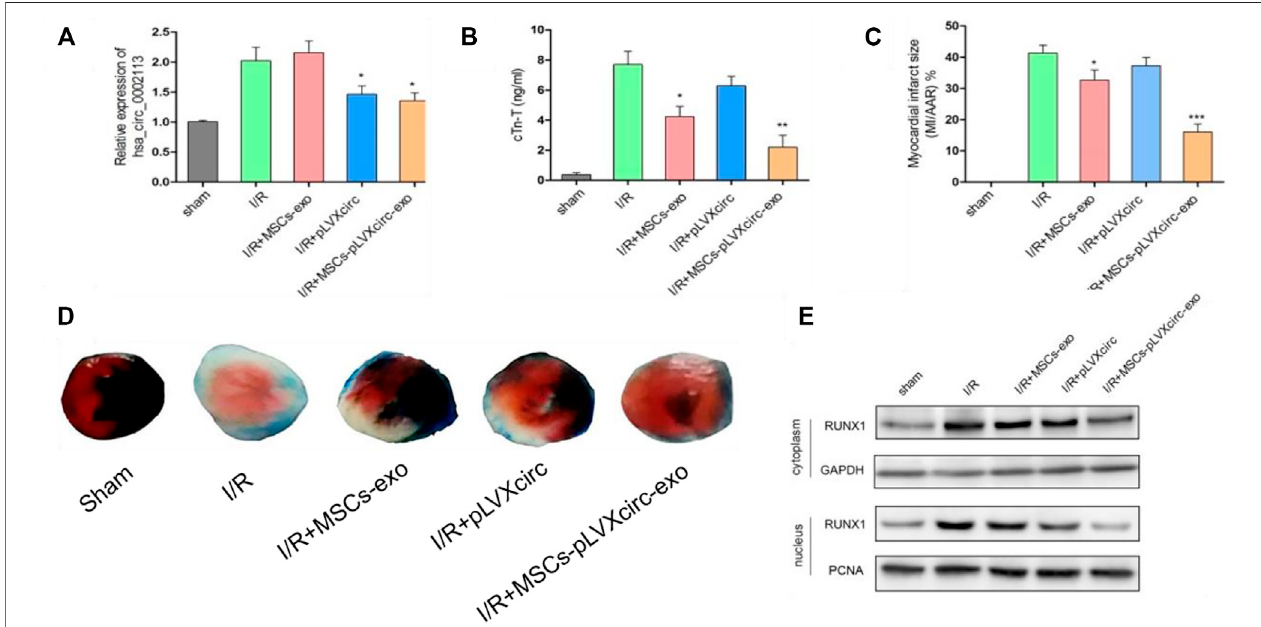
FIGURE 6 | Exosomes derived from pLVXcirc treated MSCs reduced the infarction size 4 weeks post-surgery. (A) The circRNA_0002113 expression was evaluatedaftertreatmentwithexosomesderivedfrompLVXcirctreatedMSCs( n (cid:1) 5). (B) ExosomesderivedfrompLVXcirctreatedMSCsdecreasedcTn-Tcontentafter 4 weeks post-surgery ( n (cid:1) 5). (C,D) The TTC/Evan blue staining and quantitative infarction size 4 weeks post-surgery after treatment with exosomes isolated from pLVXcirc treated MSCs ( n (cid:1) 5). (E) The cytoplasmic and nuclear RUNX1 protein expression levels were evaluated in I/R hearts following treatment with exosomes isolated from pLVXcirc treated MSCs ( n (cid:1) 5). (F) The co-labeled USP7 and p53 were estimated in I/R hearts following treatment with exosomes isolated from pLVXcirc treated MSCs. Scale bar: 50 μ m * p < 0.05, ** p < 0.01, *** p < 0.001, compared with I/R